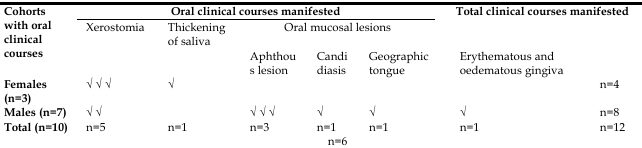
Table 1: Oral clinical courses (√) in patients with SARS -CoV-2 infection